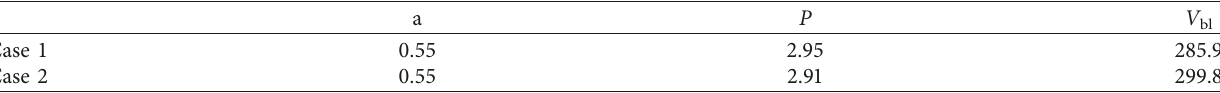
Table 8: Ballistic limits and model constants of numerical simulation for Q235B steel targets.